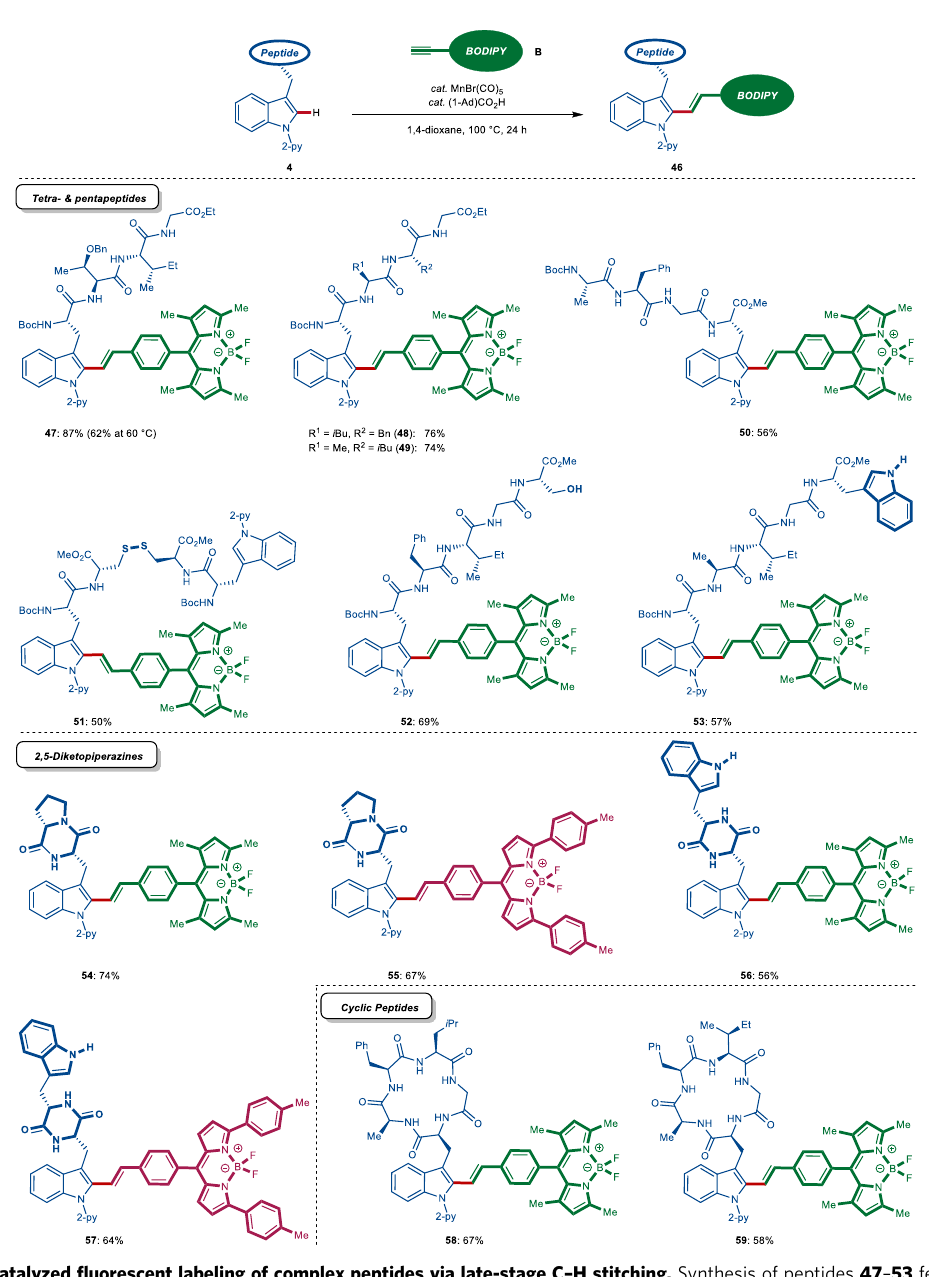
Fig. 4 Manganese-catalyzed fl uorescent labeling of complex peptides via late-stage C – H stitching. Synthesis of peptides 47 – 53 featuring a bent linker between the BODIPY fl uorophore and the tryptophan via C – H stitching, late-stage diversi fi cation of natural product derivatives featuring the 2,5- diketopiperazine core ( 54 – 57 ) and synthesis of fl uorescent cyclic peptides via C – H